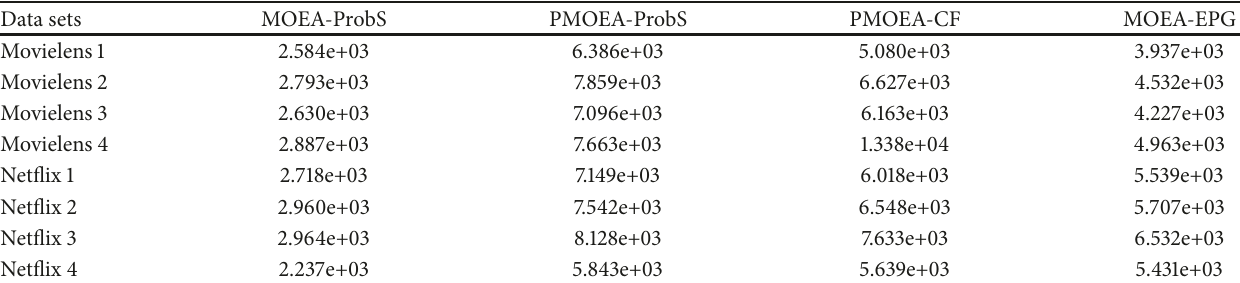
Table 9: Average execution times in seconds of all the MOEAs based recommendation algorithms over 30 independent trials. Data